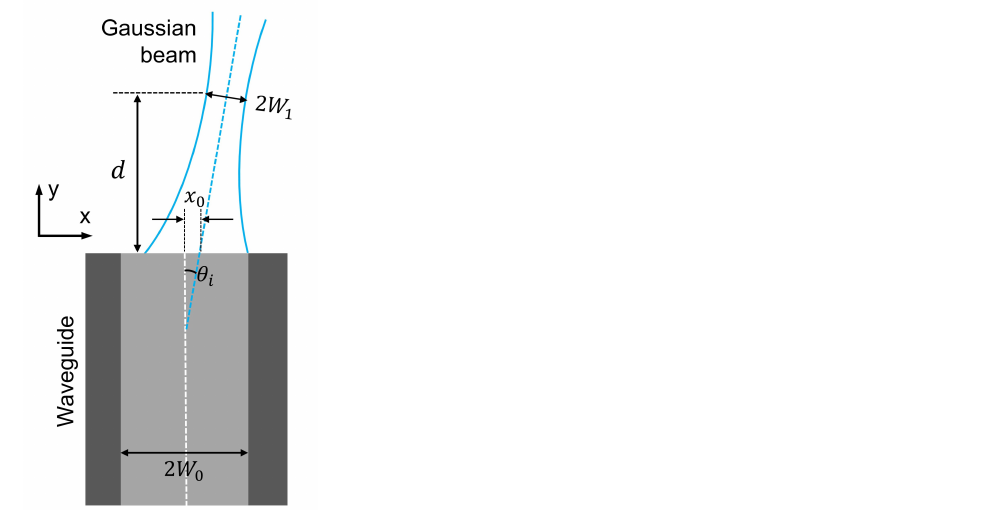
Figure 2. A sketch displaying a Gaussian beam coupled to a bare core-cladding